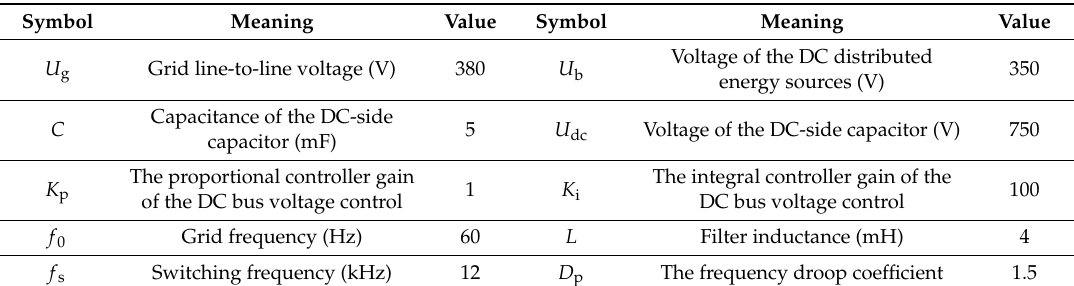
Table 2. Main parameters of real-time simulation.